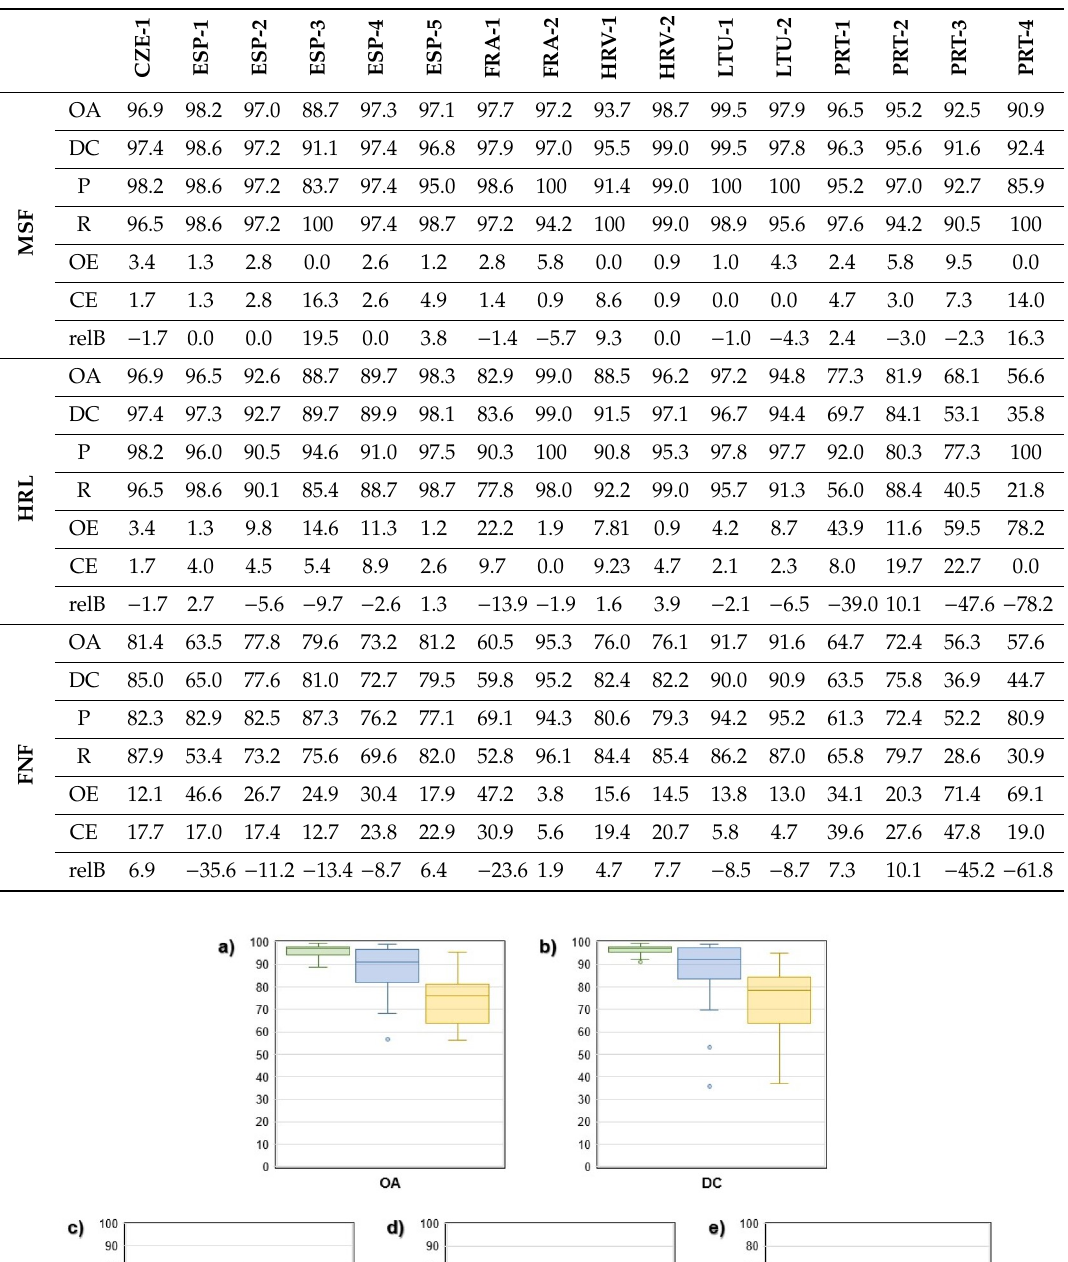
Table 6. Performance metrics of 16 AOIs grouped by product.